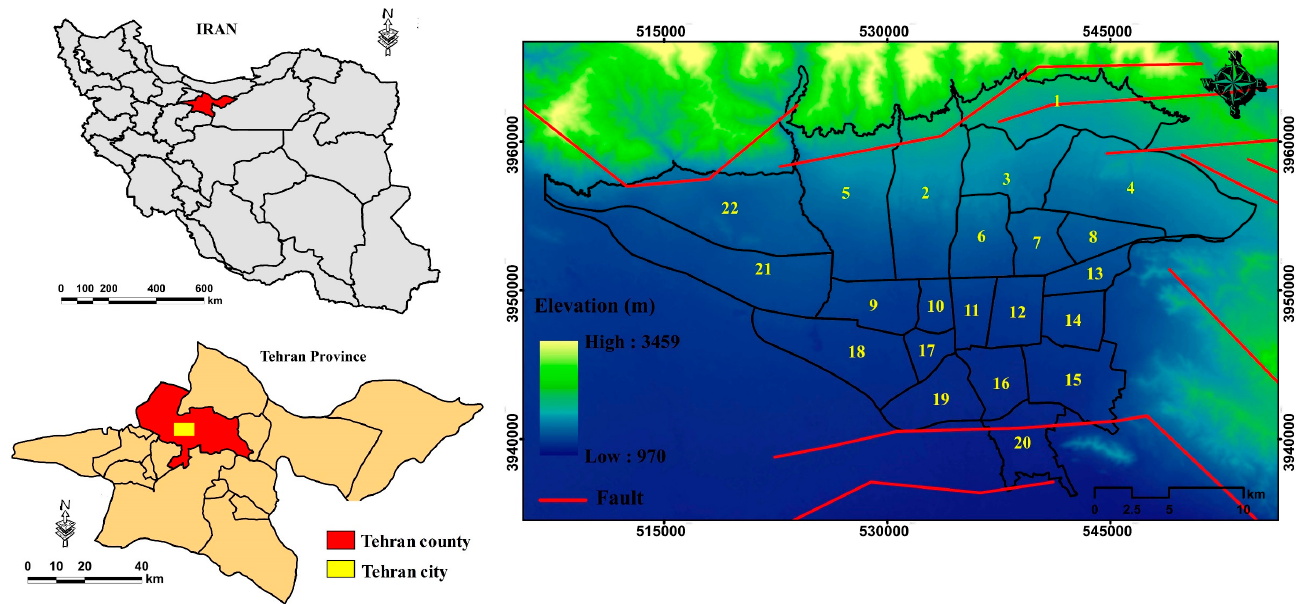
Figure 2. Geographical location and faults of the studied area (numbers 1 to 22 represent the urban districts of Tehran).